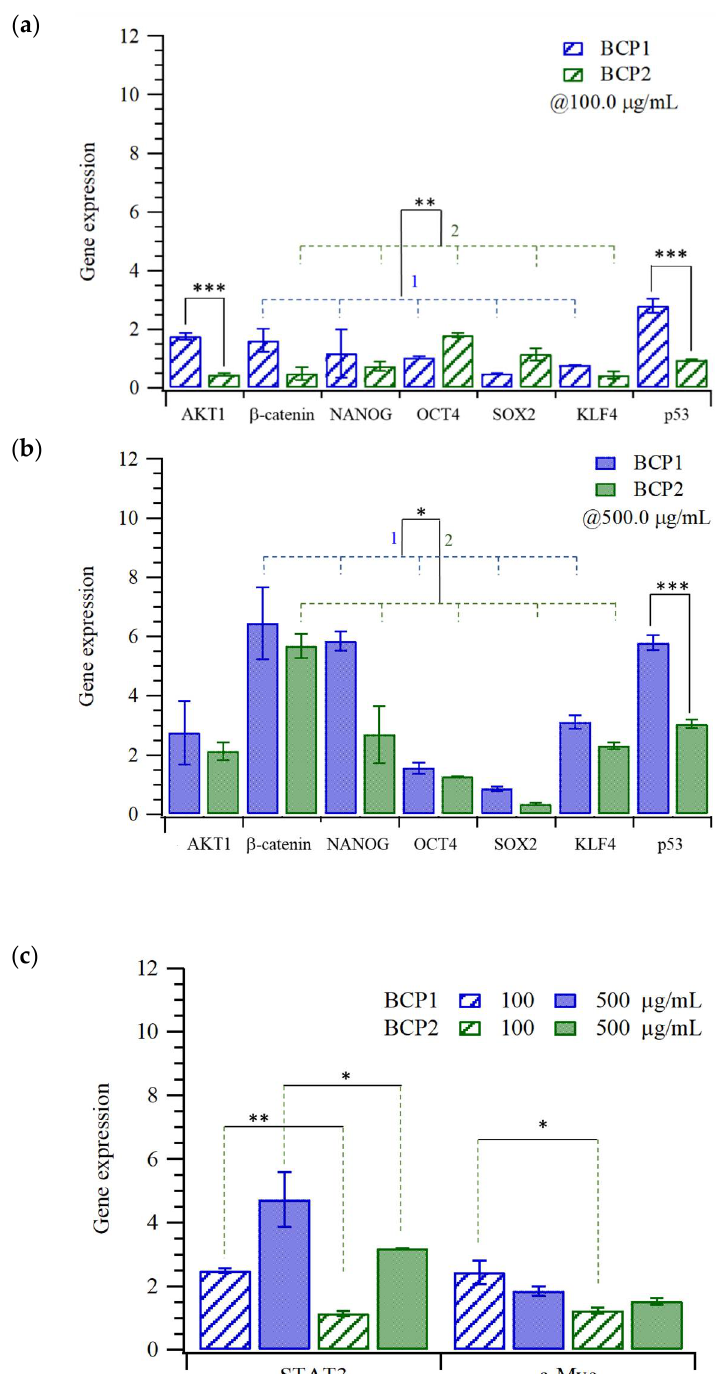
Figure 4. Expression levels (relative to unexposed controls) of key factors in differentiation/self- renewal pathways of iPSC with ( a ) 100 and ( b ) 500 µ g/mL of BCPs; ( c ) comparison of the expression of STAT3 and c-Myc of iPSC incubated with 100 and 500 µ g/mL of BCPs (* p < 0.05; ** p < 0.005; *** p < 0.0005).